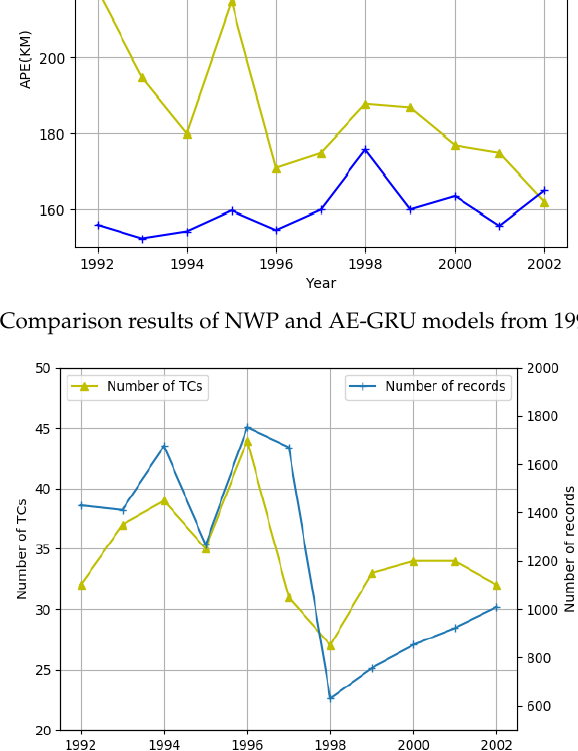
Figure 7. Number of effective tropical cyclones and records per year from 1992 to